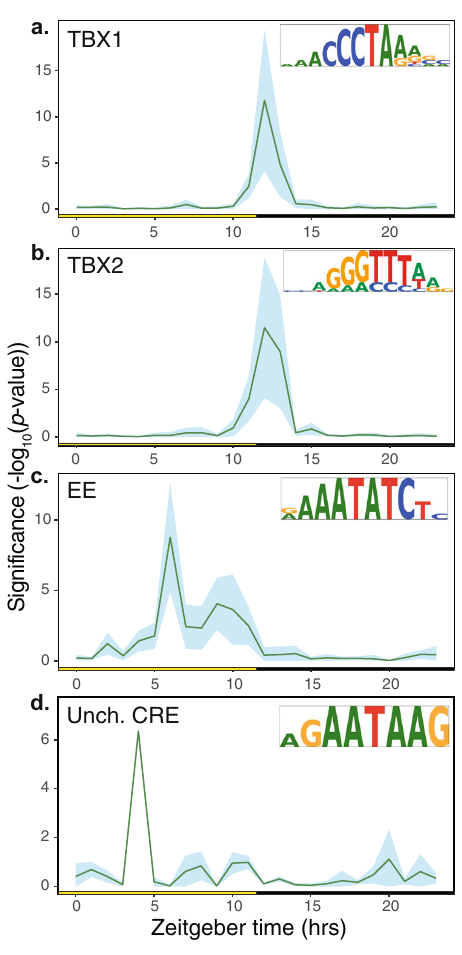
Fig. 5 Expression of key circadian associated genes is shifted in I. taiwanensis . a LATE ELONGATED HYPOCOTYL (LHY) , b PSEUDO- RESPONSE REGULATOR 1 ( PRR1 ), c GIGANTEA ( GI ) orthologs in Isoetes (blue lines), Selaginella (orange line), and Arabidopsis (red line) normalized expression over the day. Day (yellow box); night (black box); Zeitgeber time (ZT) is the number of hours (h) after lights on (0 h). Locus IDs for genes used in expression plots can be found in Supplementary Data 3. Source data for I. taiwanensis are provided in Supplementary Data 2. Source data for the other taxa are provided as a Source Data fi le.